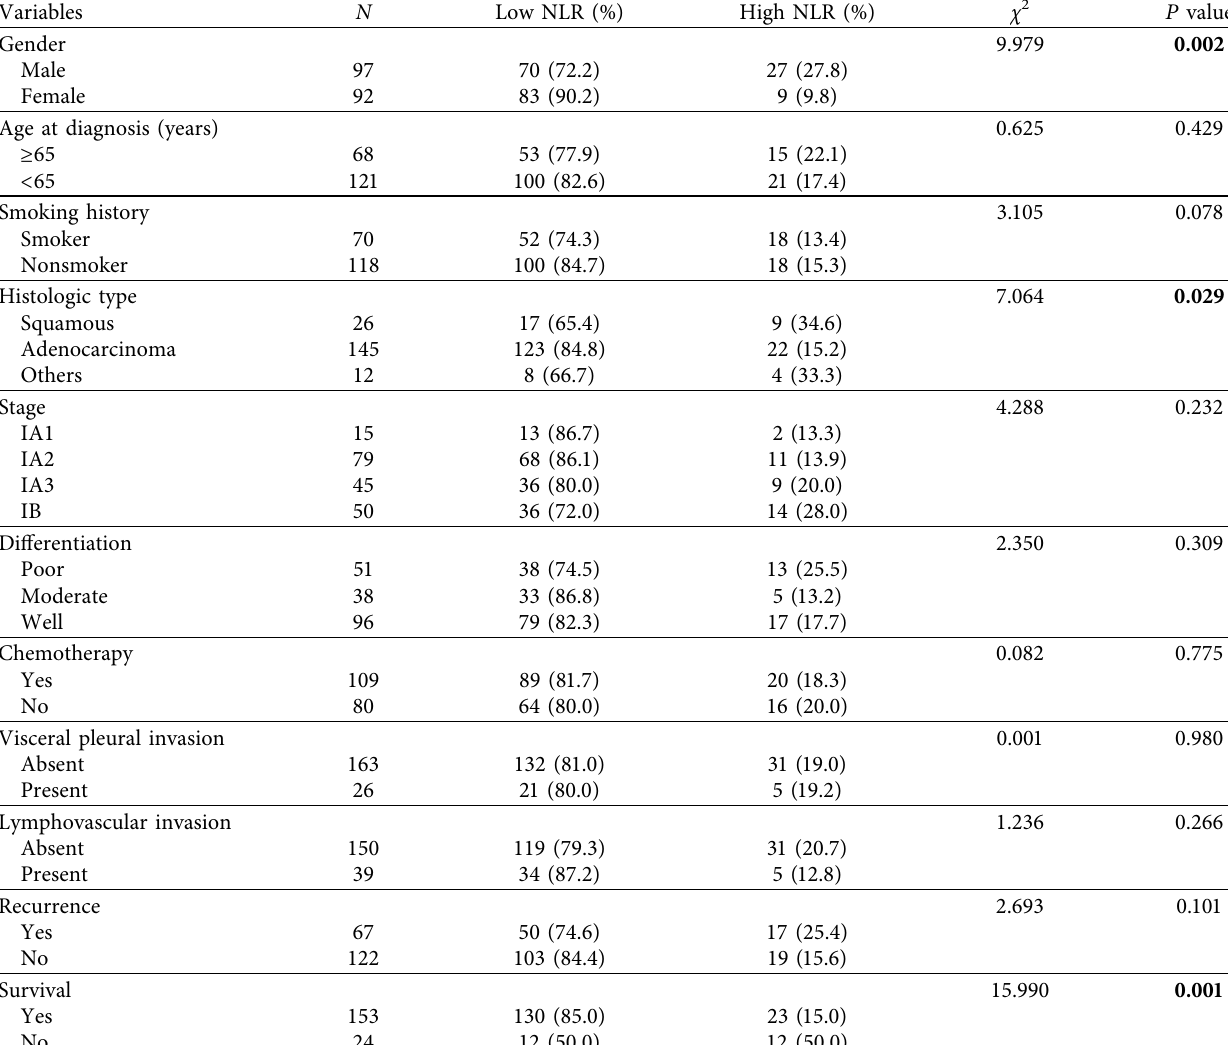
Table 2: Relationship between clinical, pathological, and NLR in postoperative stage I NSCLC